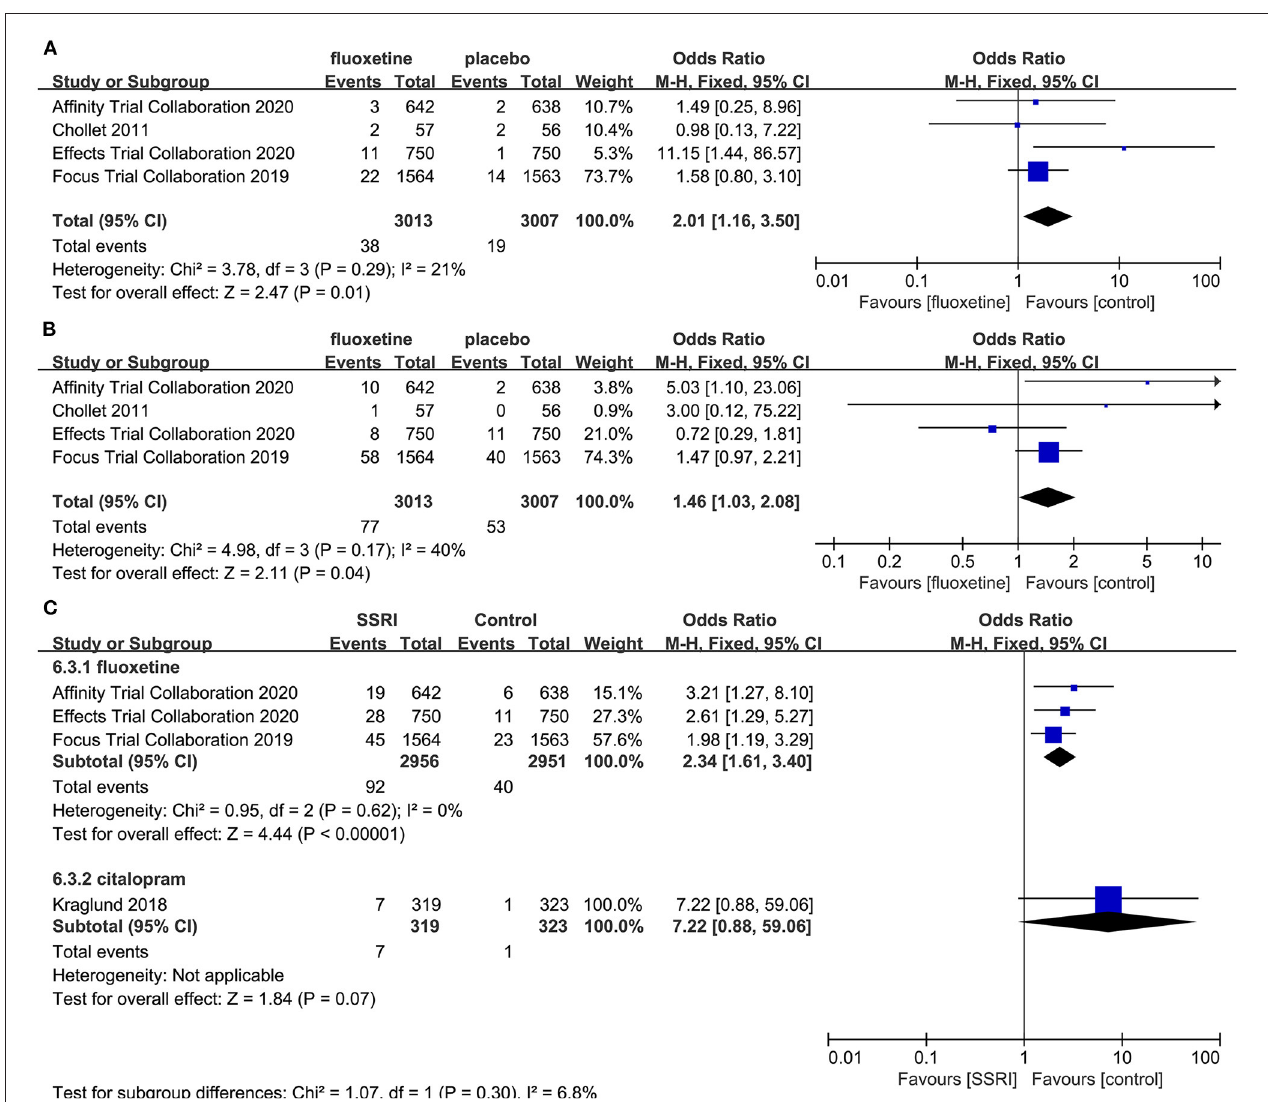
FIGURE 7 | Forest plot of adverse events. (A) hyponatremia, (B) seizure, (C)